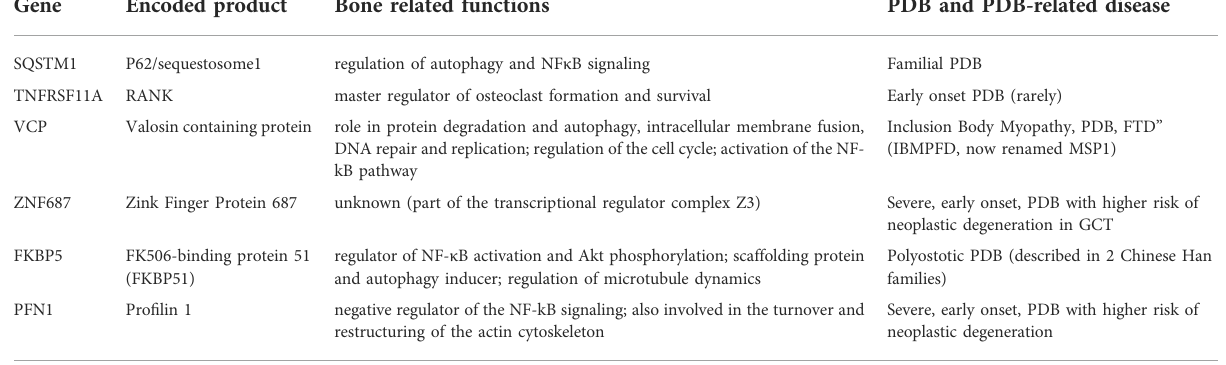
TABLE 1 Germline Mutations associated with PDB and/or PDB related disorders and their